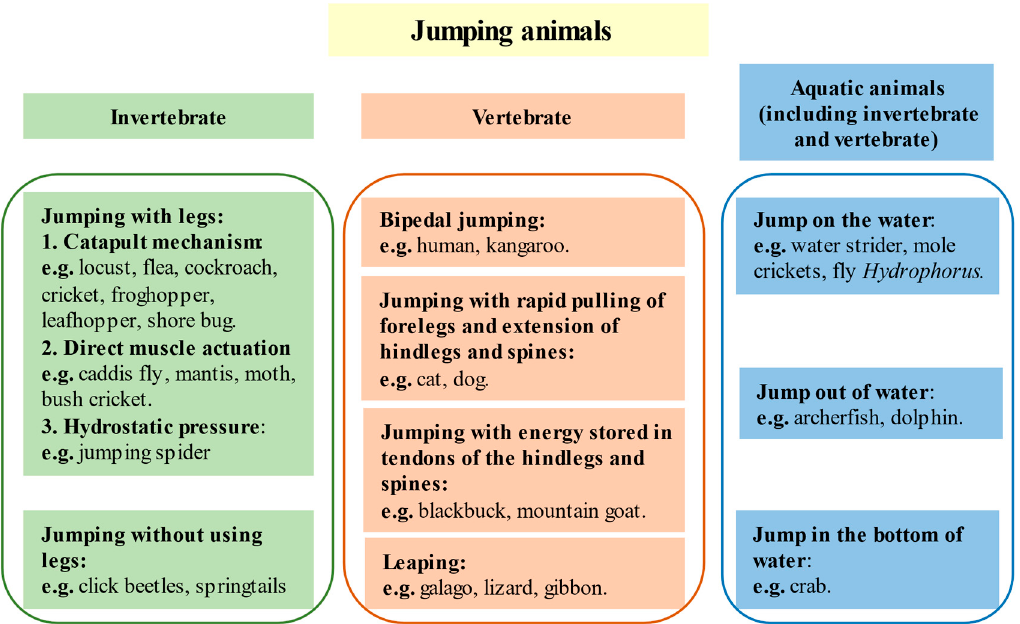
Figure 2. Classification of jumping animals in three subcategories: invertebrate, vertebrate, and aquatic jumping animals (including invertebrate and vertebrate animals).